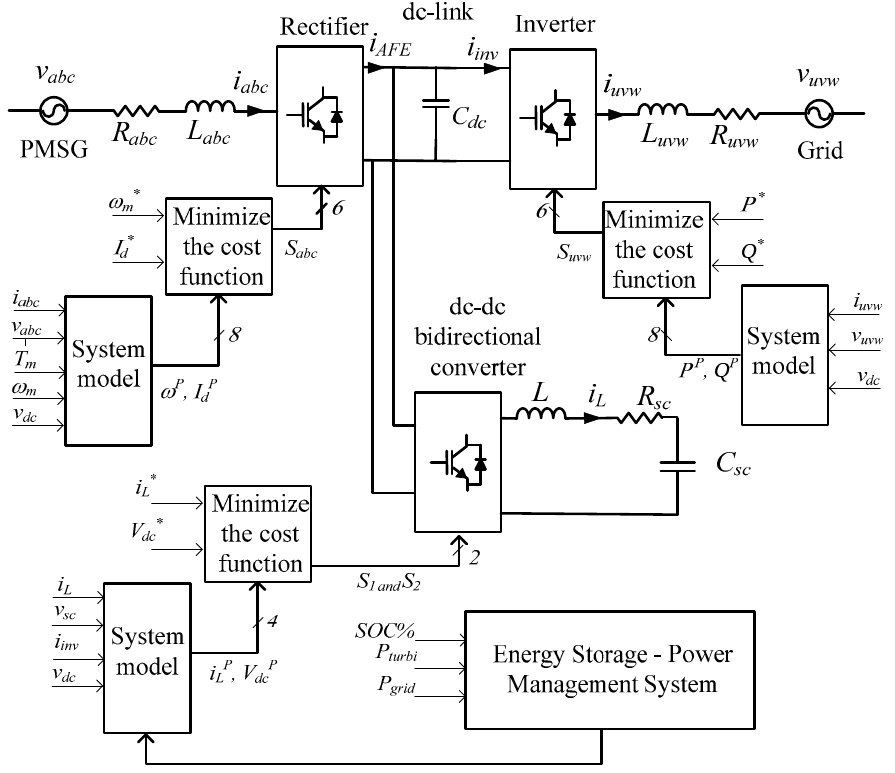
Figure 2. Schematic diagram of the proposed controllers for the grid integration of an OWC unidirectional air turbine generator with a hybrid energy storage system (HESS).